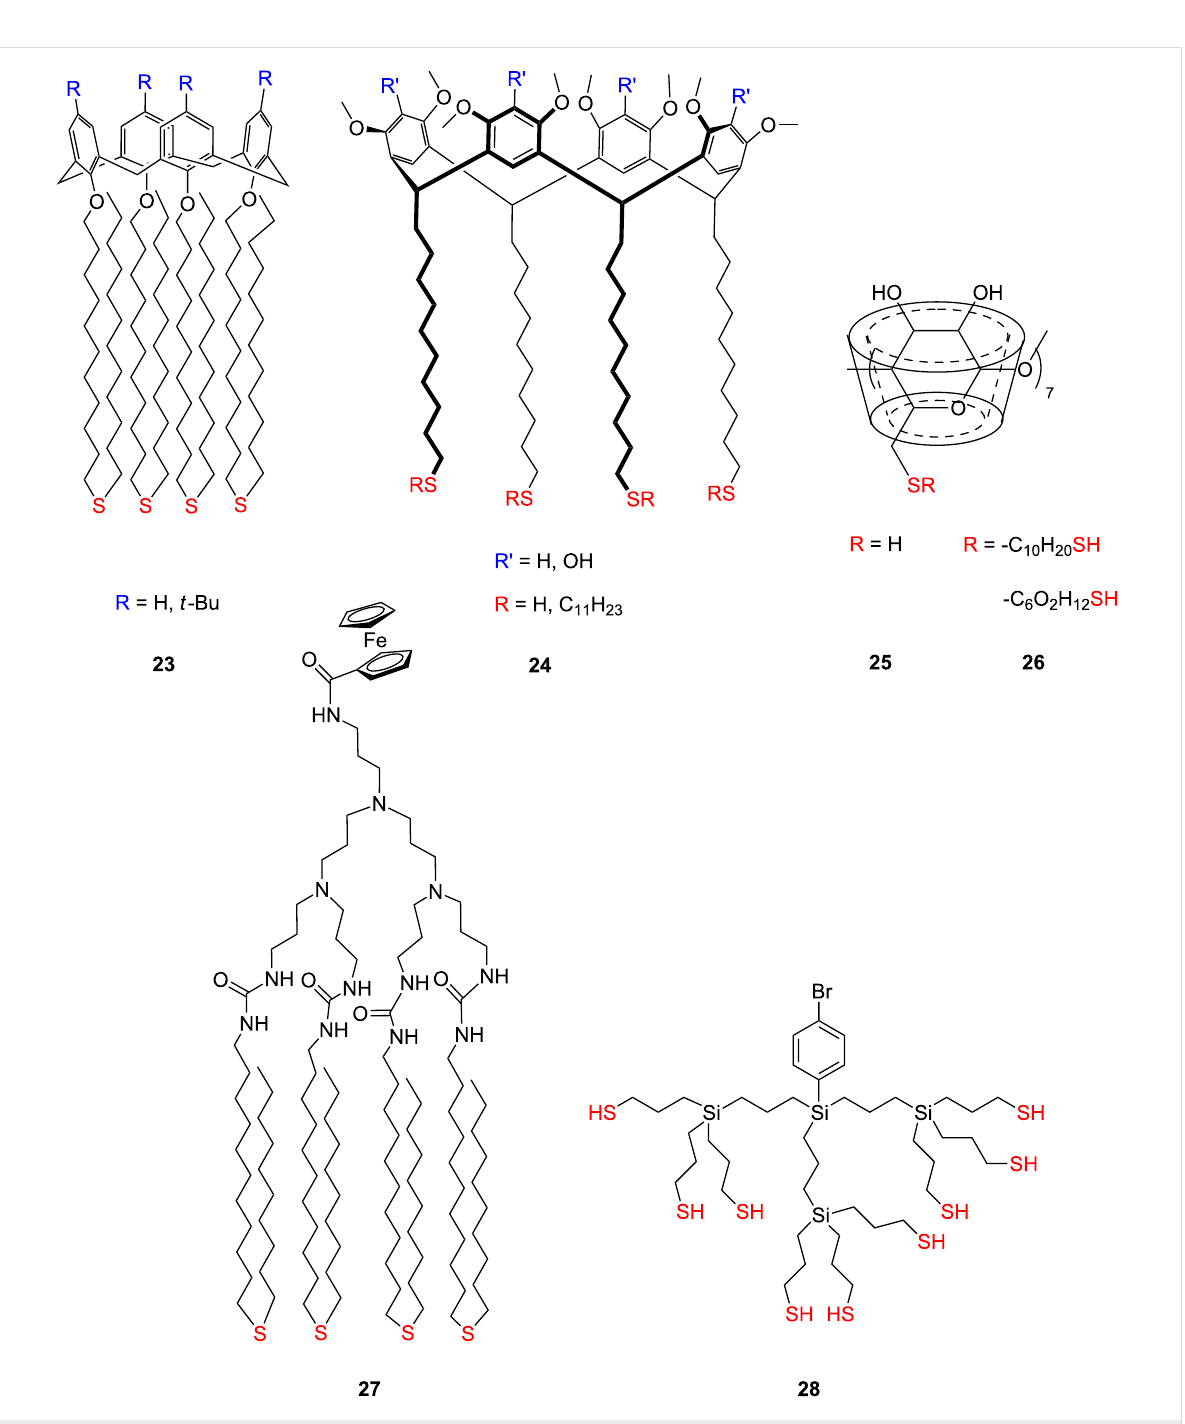
that the packing within the SAM of shorter oligothiophene- terminated tripods ( n = 1) is more compact than that of the longer ones [125]. In the following series of tower-shaped mol- ecules there are two factors that significantly lower molecular order in monolayers on gold surfaces, the increasing length of rod-like oligothiophene moieties standing upwards on the sur-